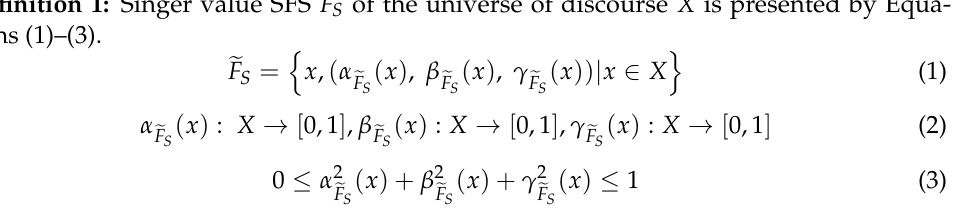
Figure 2. Geometric representation of SFS in 3D space [42].